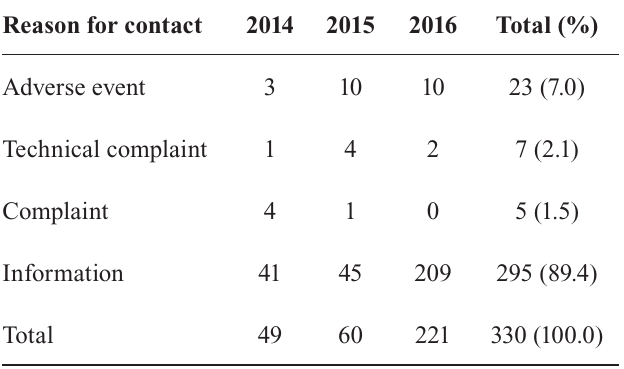
TABLE II - Reason for consulting the Custumer Service Departament